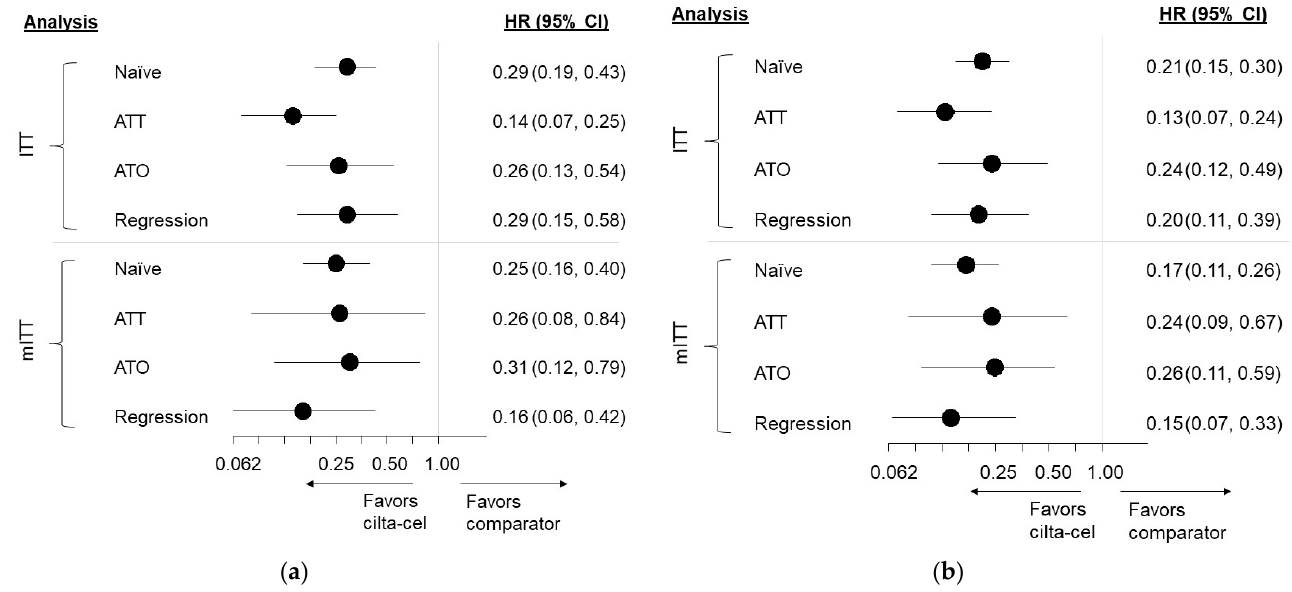
Figure 2. Findings from Adjusted Comparisons, OS and TTNT. Forest plots presenting hazard ratios comparing cilta-cel and RWCP with corresponding 95% CIs for ( a ) OS and ( b ) TTNT are shown for both ITT and mITT populations. Both the unadjusted comparison as well as adjusted comparisons derived using IPW methods and Cox proportional hazards regression are shown. Findings for both endpoints consistently suggest increased benefits with cilta-cel compared to RWCP. Abbreviations: ATT = average treatment effect in the treated population; ATO = average treatment effect in the overlap population; CI = confidence interval; HR = hazard ratio; ITT = intention to treat; mITT = modified intention to treat.